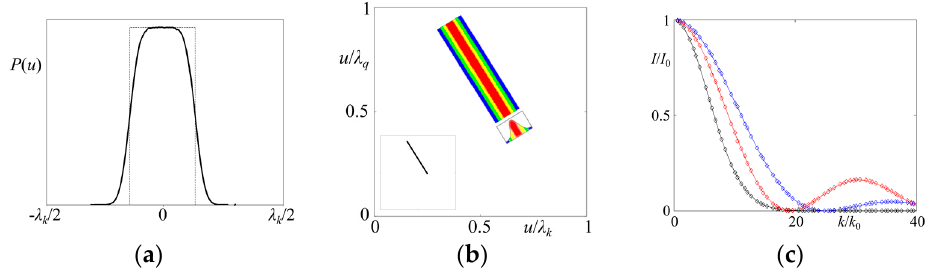
Figure 8. ( a ) Modified marginal distribution P ( u ) of the Fibonacci chain with phonons (original shape for ideal structure marked with dotted line); ( b ) TAU2-scaling relation for Fibonacci chain modified by Gaussian phononic smearing. Respective v ( u ) relation for ideal structure shown in the inset. In both plots the amplitude of phonons was 2% of λ k ; ( c ) Envelope functions of the diffraction peaks for the Fibonacci chain with phononic disorder corrected by three different multiplicative correction functions: Gaussian (standard Debye-Waller factor black), Bessel (red) and cardinal sine (blue) plotted relative to intensities calculated for ideal structure with no phonons. Main scattering vector k 0 = 2 πτ (cid:3099) (cid:3118) (cid:2878)(cid:2869) τ 2 + 1